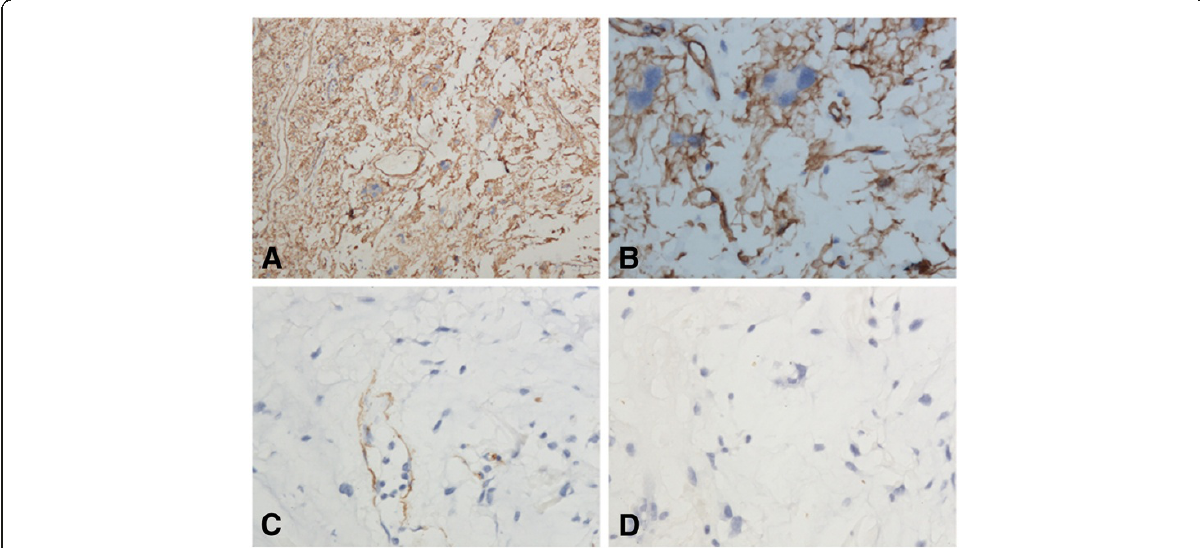
Figure 2 A, Diffuse and strong CD34 staining highlighted the tumor cells. B , The floret-like cells were positive for CD34. C , The spindle cells and floret-like cells were negative for SMA, while SMA staining highlighted the dilated vessel. D , All tumor cells including floret-like cells were negative for